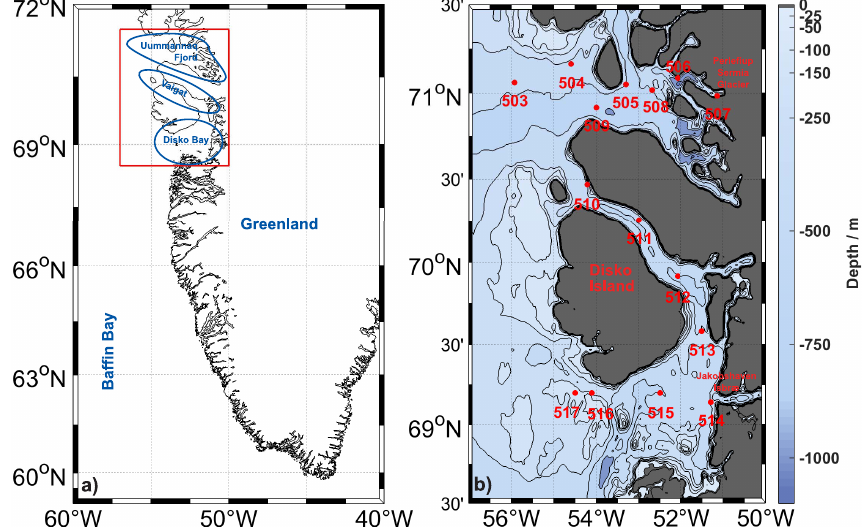
Figure 1. (a) Map of Greenland and parts of Baffin Bay; (b) study area: Uummannaq Fjord, Vaigat and Disko Bay (West Greenland) with stations (red dots) and under water topography (data from Amante and Eakins, 2009). The contour lines represent the indicated depth at the color bar next to the